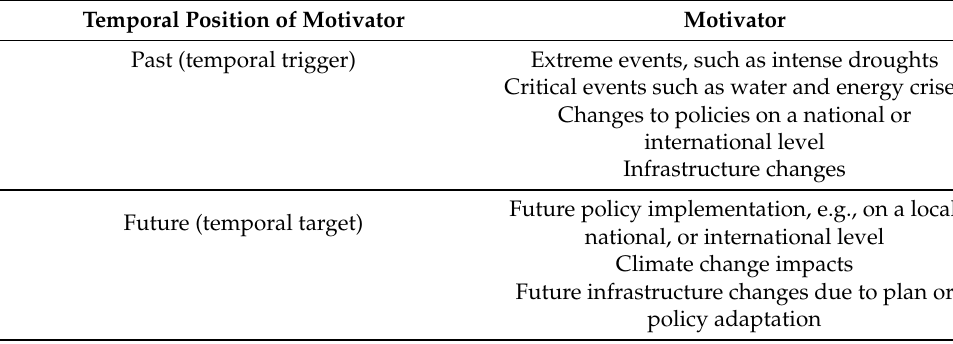
Table 1. Main motivators underlying the determined temporal